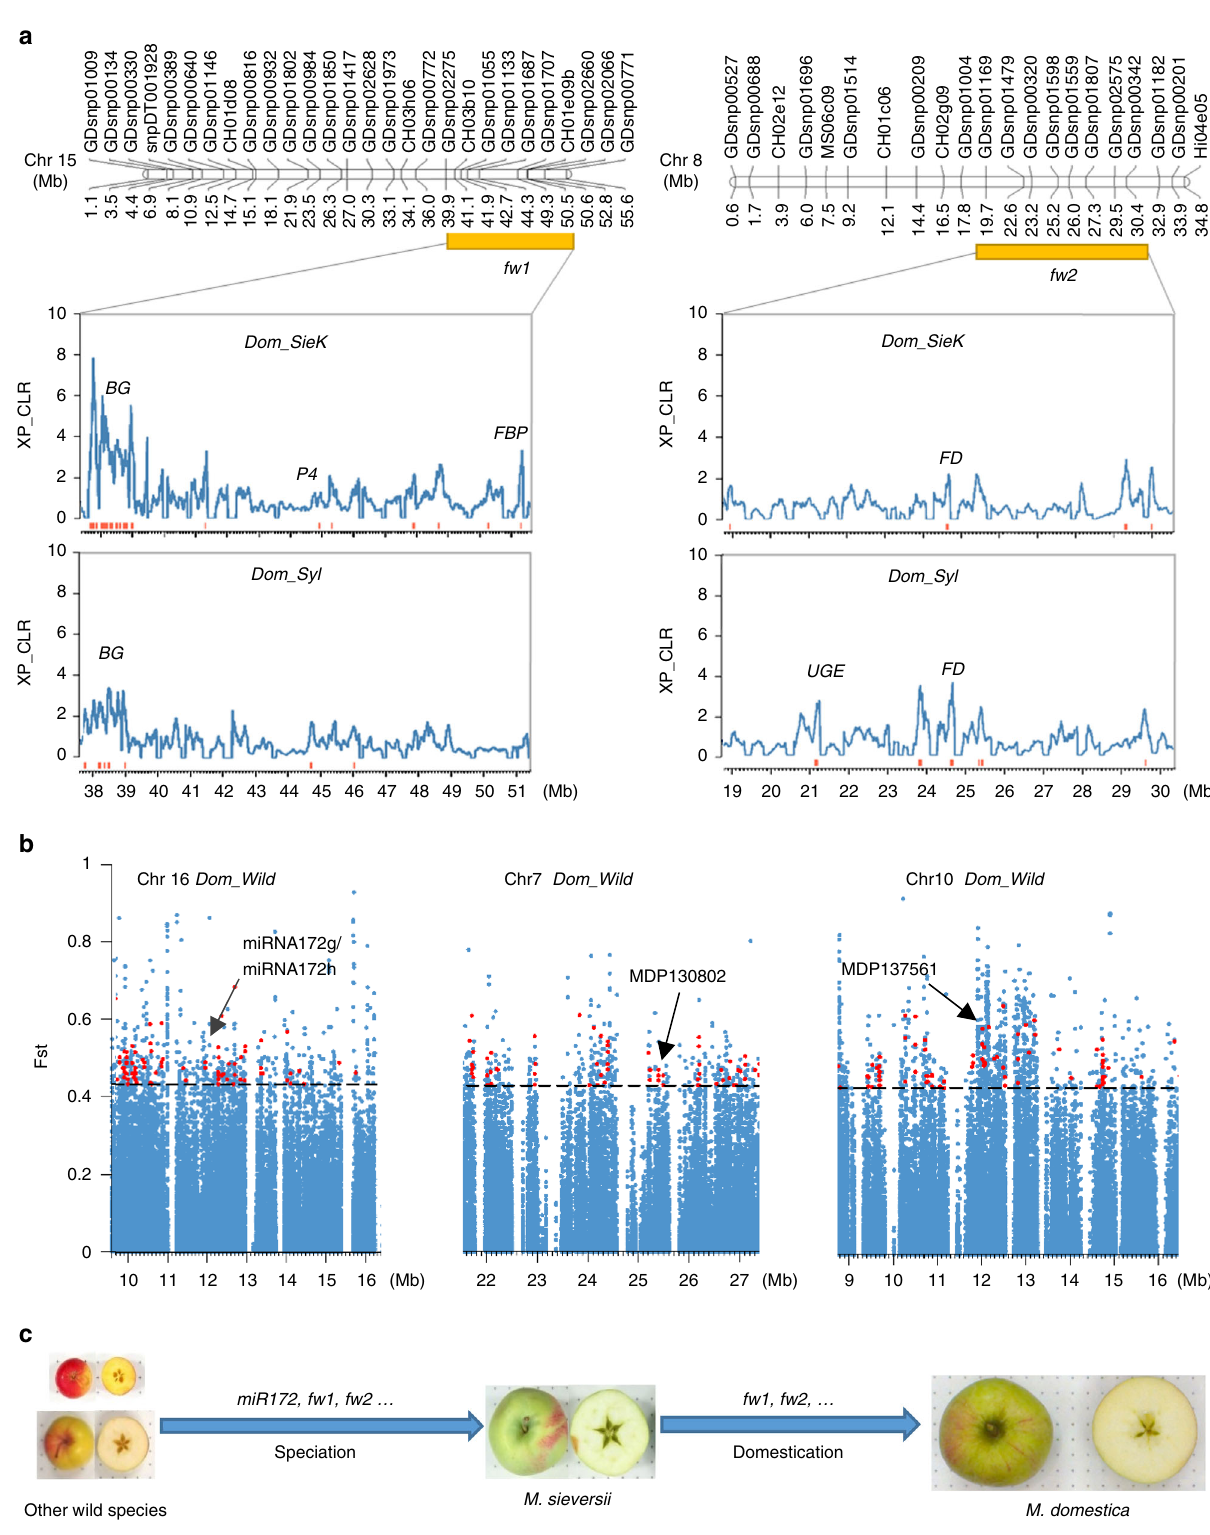
Fig. 4 Evolution of fruit size during speciation and domestication in apple. a Domestication sweeps underlying apple fruit size QTLs. Within the physical intervals ( orange boxes ) of the two fruit weight QTLs fw1 and fw2 , distributions of XP-CLR scores are shown. Selective sweeps are marked with red bars and interesting genes are labeled above peaks. b MiRNA172g/miRNA172h and the two target genes that contain highly divergent SNPs (pointed by arrows ) between M. domestica with large fruits and other wild species bearing very small fruits. c Schematic diagram of the two-step evolution of apple fruit size. BG beta-galactosidase, FBP fructose-1,6-bisphosphatase, FD ferredoxin, PPD pyruvate phosphate dikinase, P4 patellin-4, UGE UDP-glucose